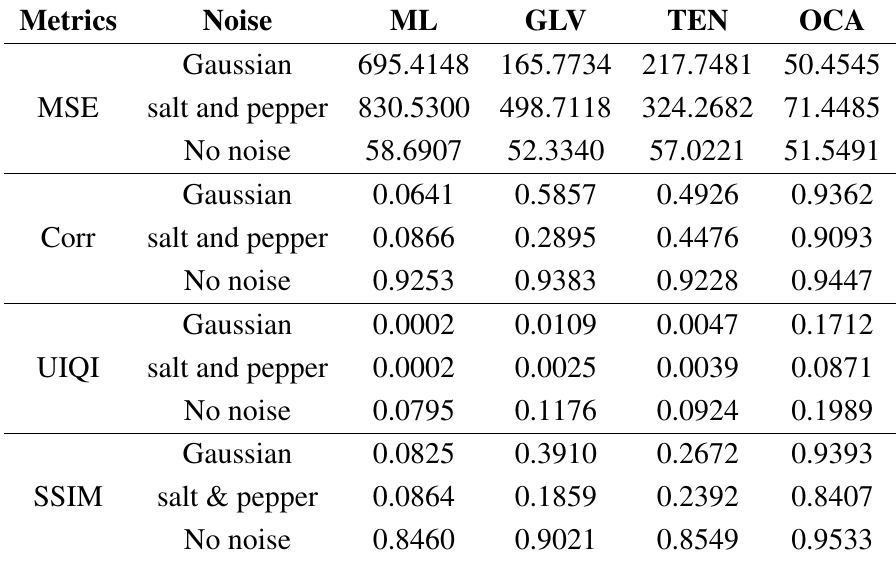
Table 3. Comparison of SFF methods with Gaussian noise (zero mean and 0.01 variance) and salt and pepper noise (noise density